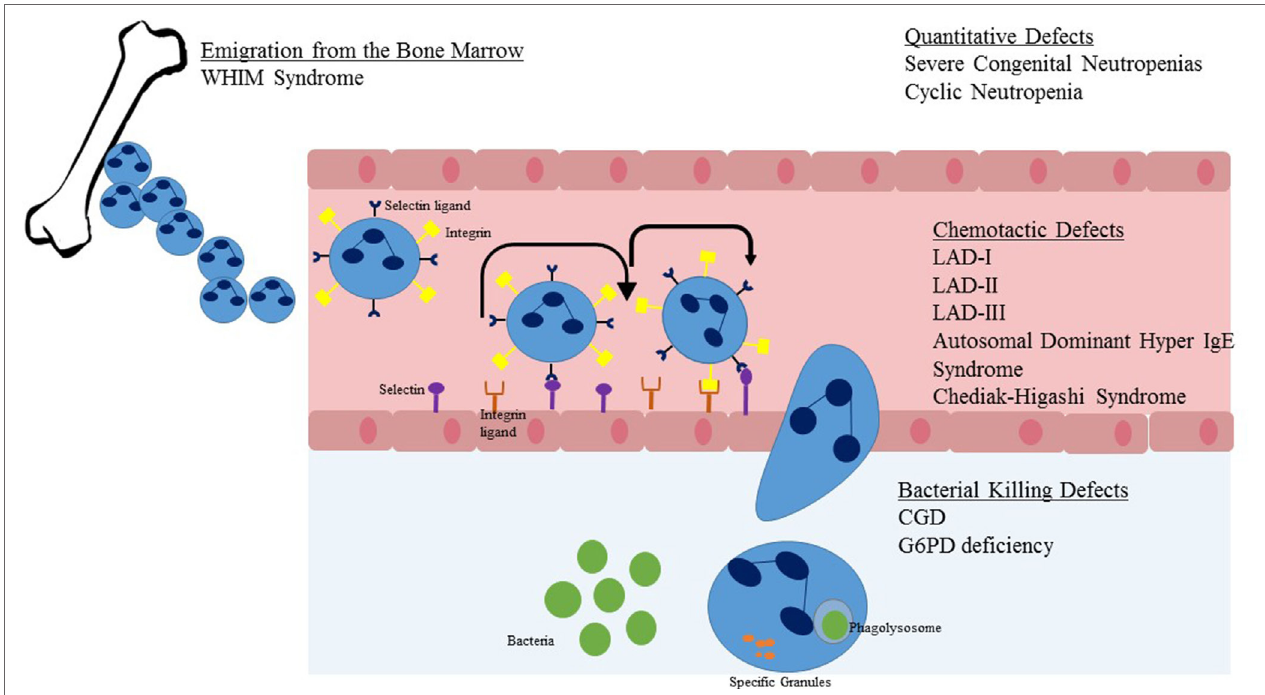
FigURe 2 | Steps in neutrophil migration from the marrow to sites of infection. Upon emigration from the bone marrow, the neutrophil travels within blood vessels. Once stimulated by chemokines or infectious pathogens in the tissue, the neutrophil begins a process of rolling adhesion to the endothelial surface and eventual migration through the endothelial wall. Once at the site of infection, the NADPH oxidase system is activated and granules are released to cause direct killing of the pathogen. Listed in text are neutrophil defects associated with the individual steps of neutrophil migration and